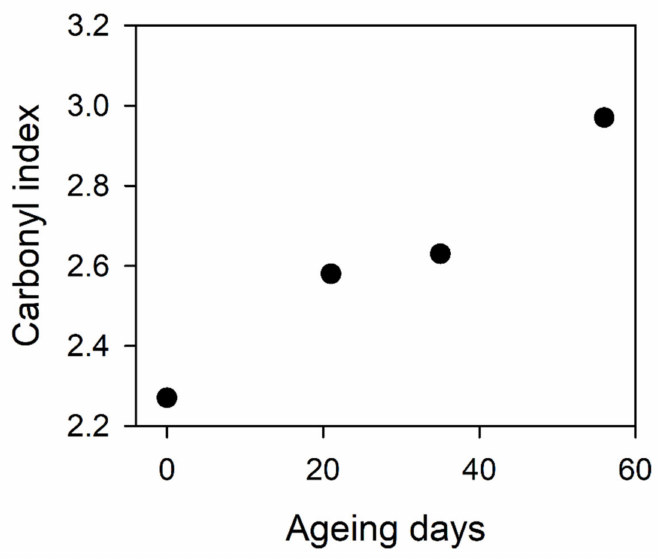
Figure 1. Carbonyl index as a function of ageing time for a series of PET samples.